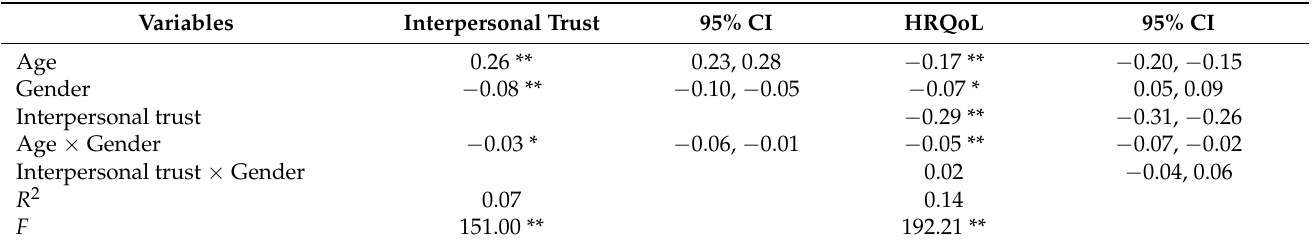
Table 4. Moderated mediating effect analyses.